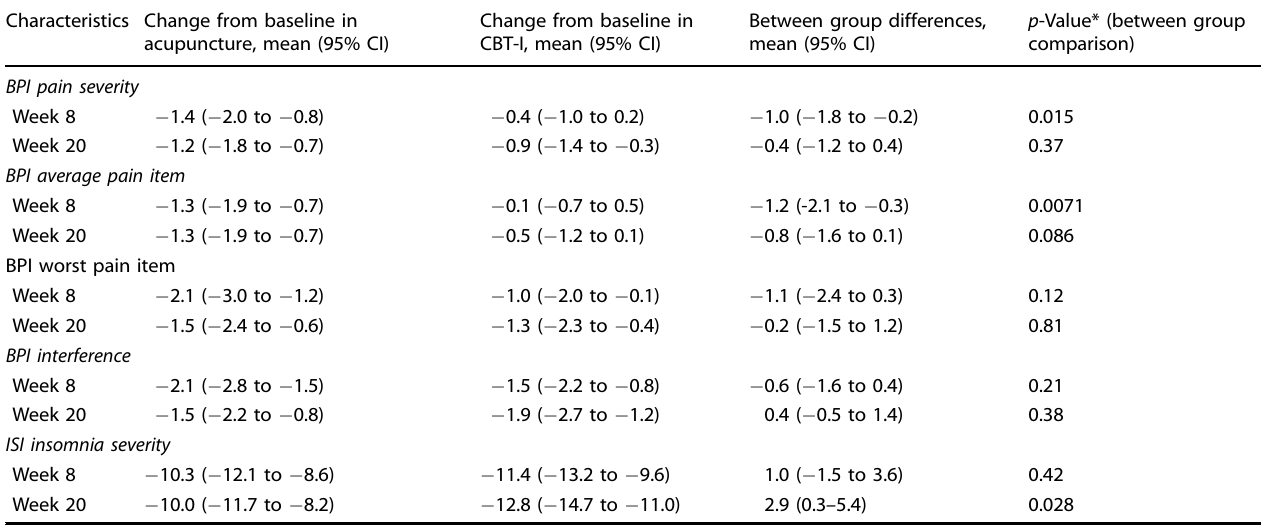
Table 2. Change in study outcomes from baseline by